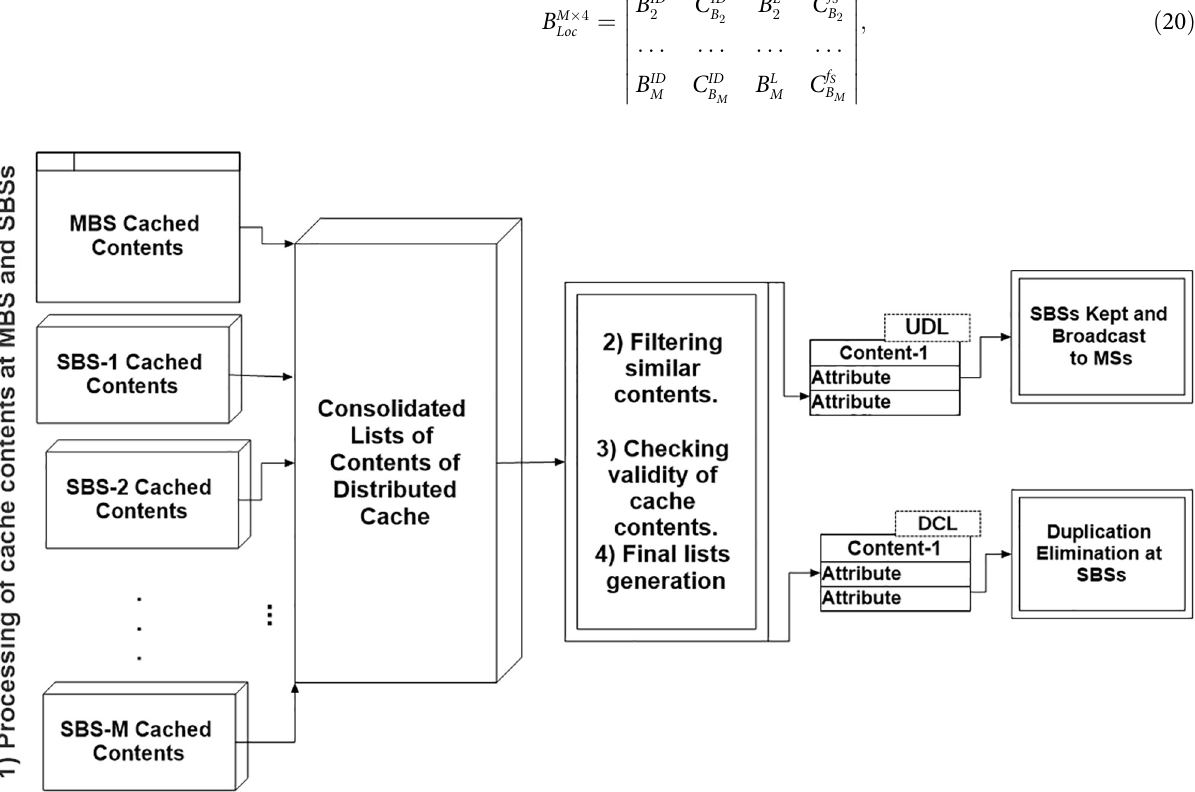
Fig 3. Preparing and generating the final list of cache